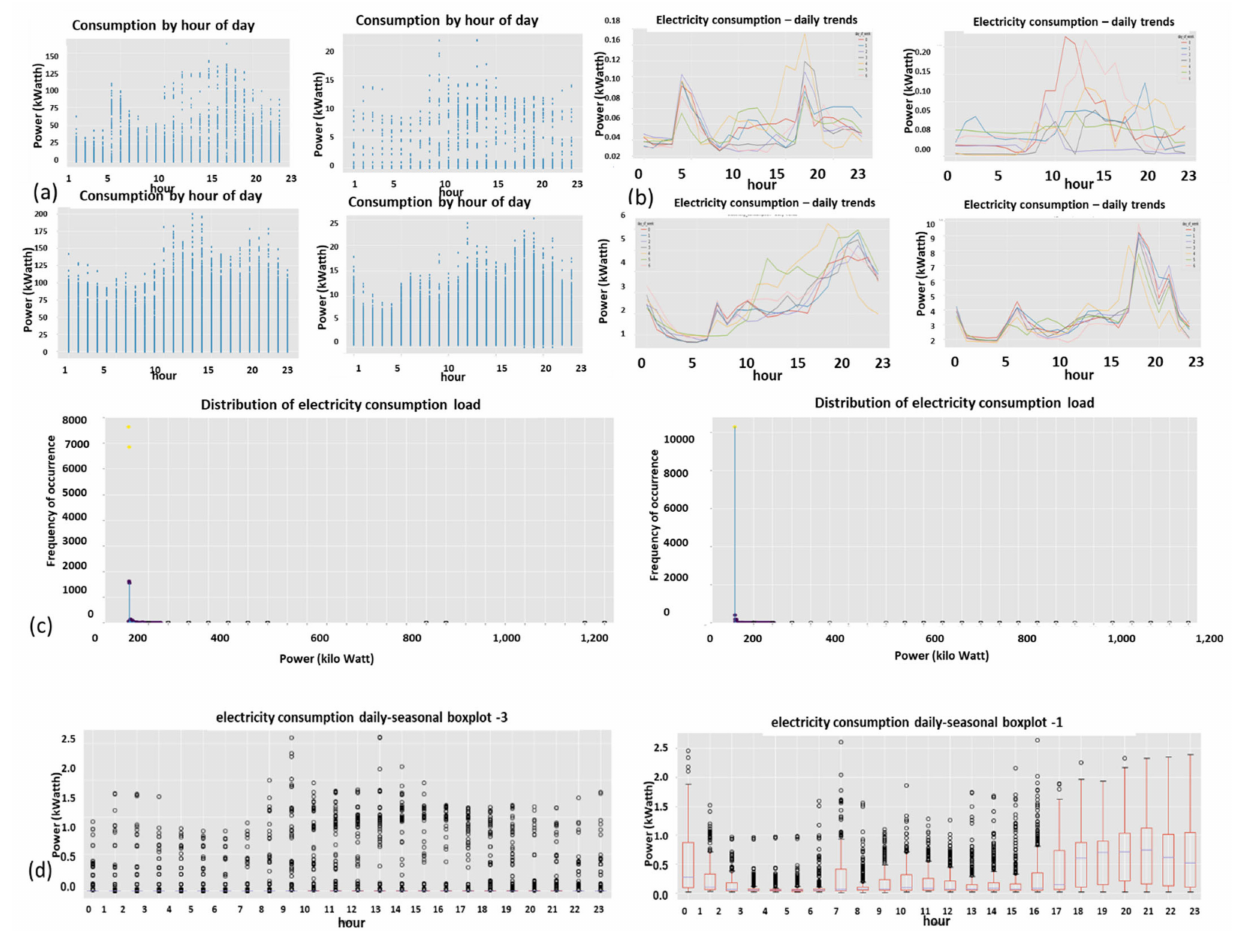
Figure 20. Sample features generated by the module. ( a ) Scatter plots, ( b ) daily-hourly trends of the same occasions. ( c ) energy distribution, ( d ) seasonal-hourly